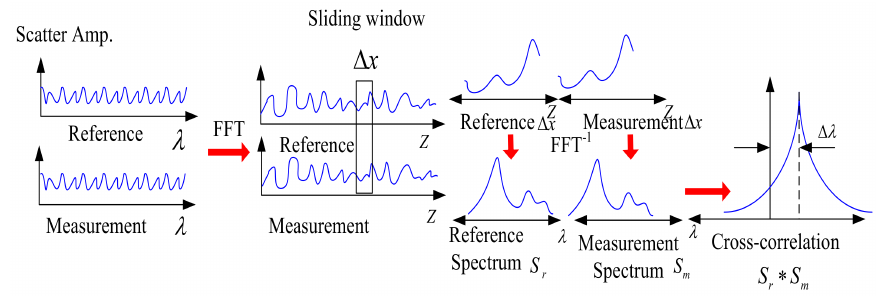
Figure 16. Signal processing procedure of RBS shifts based distributed sensing in